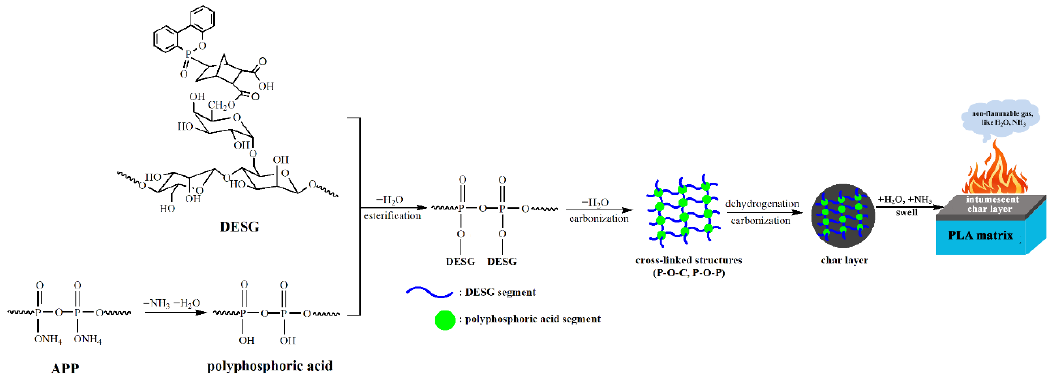
Figure 7. A possible synergistic mechanism of DESG/APP flame-retardant.